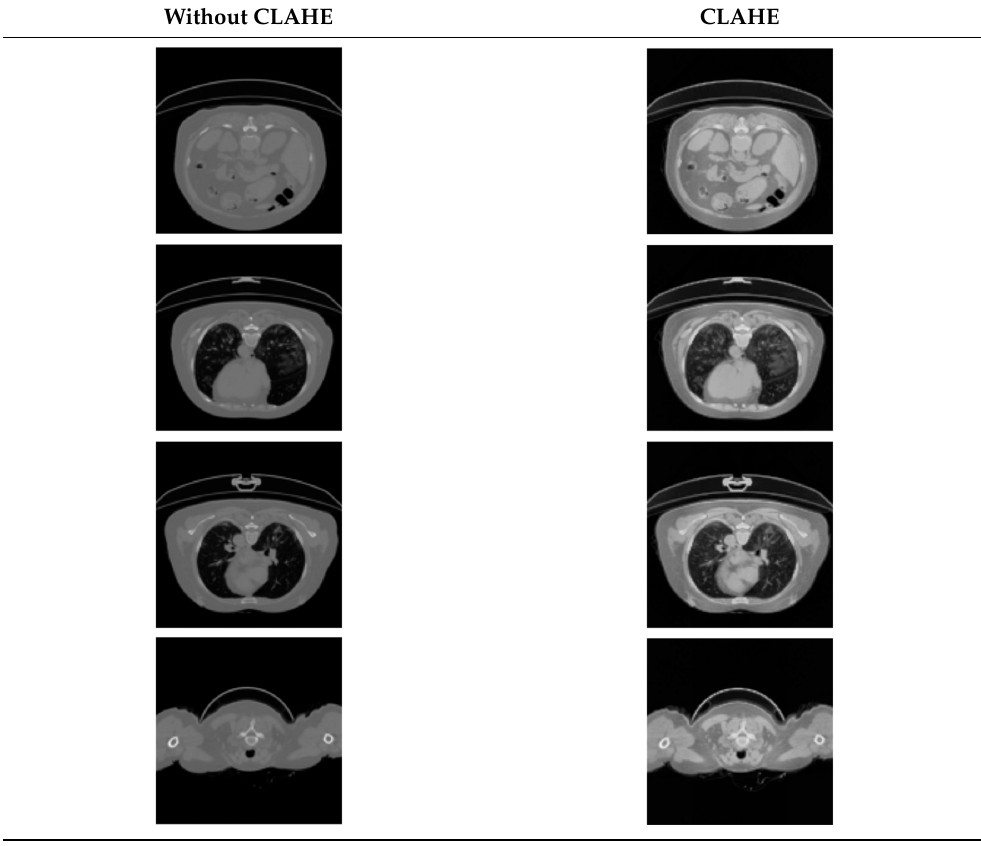
For the case of binary-class segmentation, the lung mask pixels consisting of 0: background, 1: left lung, and 2: right lung are changed to 0: background and 1: lung. The